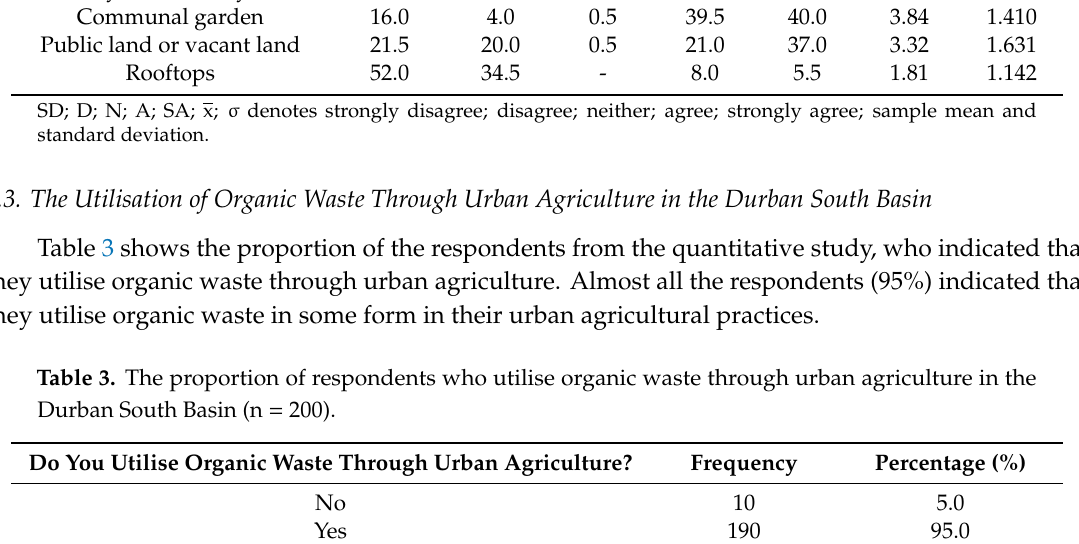
Table 2. The type of space utilised for urban farming in the Durban South Basin (n = 200). Type of Space Utilised for Urban Farming Purposes